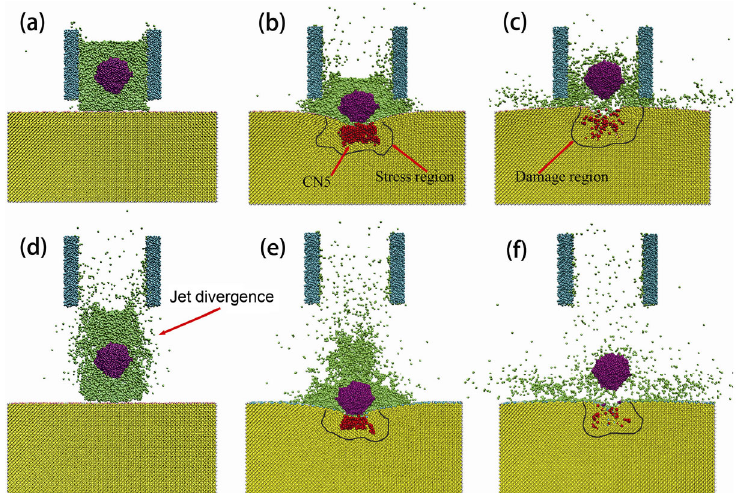
Fig. 3 Side cross-section view of the impact zone at different moments. Red particles represent CN5 atoms. (a), (b), (c) are the snapshots of 750 fs, 1,950 fs, and 6,000 fs at Pos20, respectively. (d), (e), (f) are the snapshots of 3,750 fs, 4,900 fs, and 8,000 fs at Pos150, respectively. (a) and (d) represent the moment when the jet first contacts the substrate; (b) and (e) represent the moment of the maximum of the number of CN5 atom; (c) and (f) represent the end of the impact